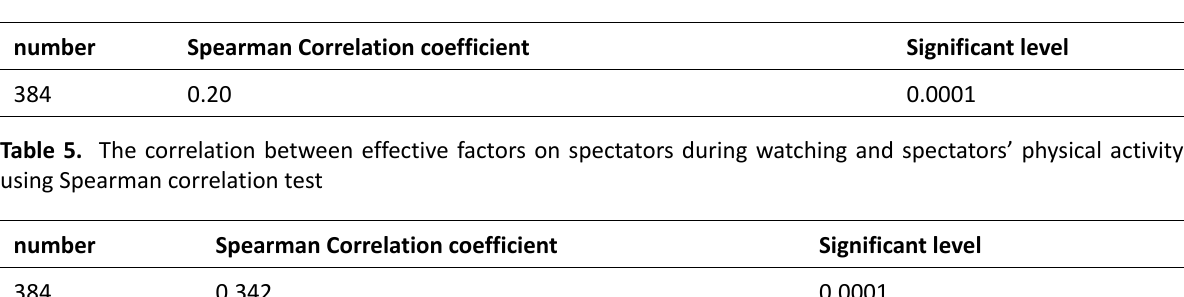
Table 4. The relationship between watching sports events in the stadium and spectators’ physical activity using Spearman correlation test